Question: Produce a descriptive caption suitable for publication.
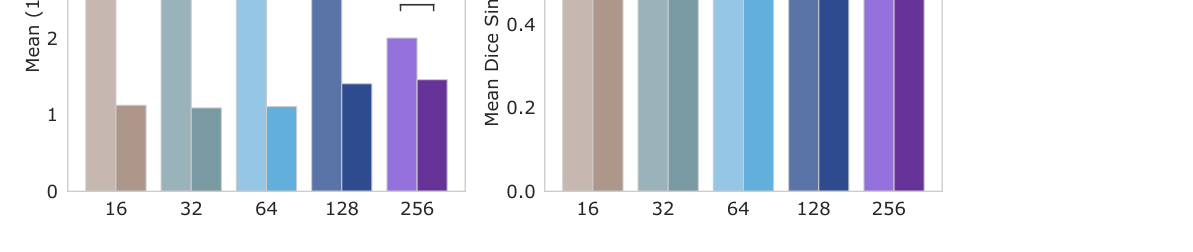
Answer: Mean over image quality (a), diagnostic confidence (b), severity of artifacts (c), and Dice similarity coefficient values (d) for lung nodule segmentations for 19 sparse-view images with (processed) and without postprocessing (sparse) by the dual-frame U-Net, labeled by three readers (n = 57). Scales defined for all labels are given in Tables Table 2 and Table 3.